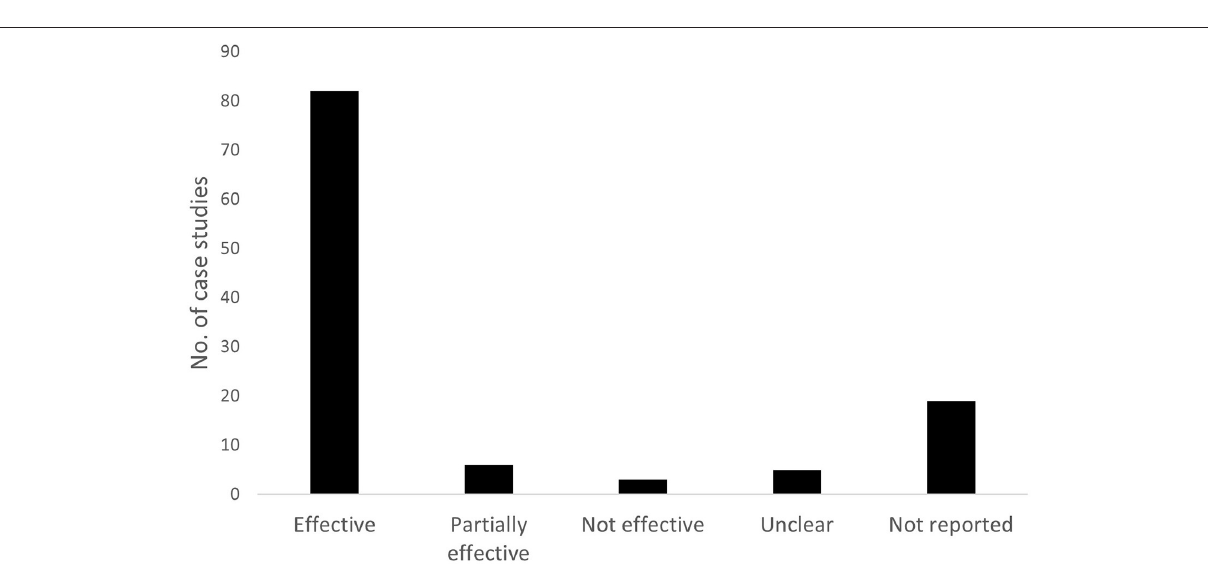
FIGURE 2 | Number of case studies, from a total of 115, reporting that they have been effective, partially effective, or not effective, in reducing IWT and poaching. The graph also includes the number of case studies that were unclear or did not report any information on